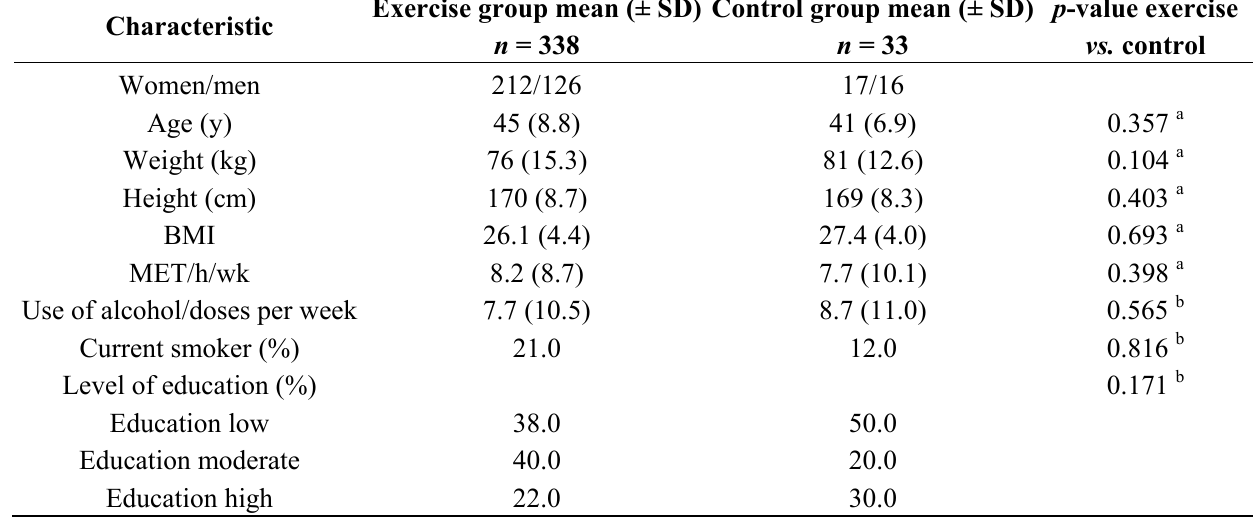
Table1. Participant characteristics of the exercise intervention group ( n = 338) and control group ( n = 33). Mean (SD), or